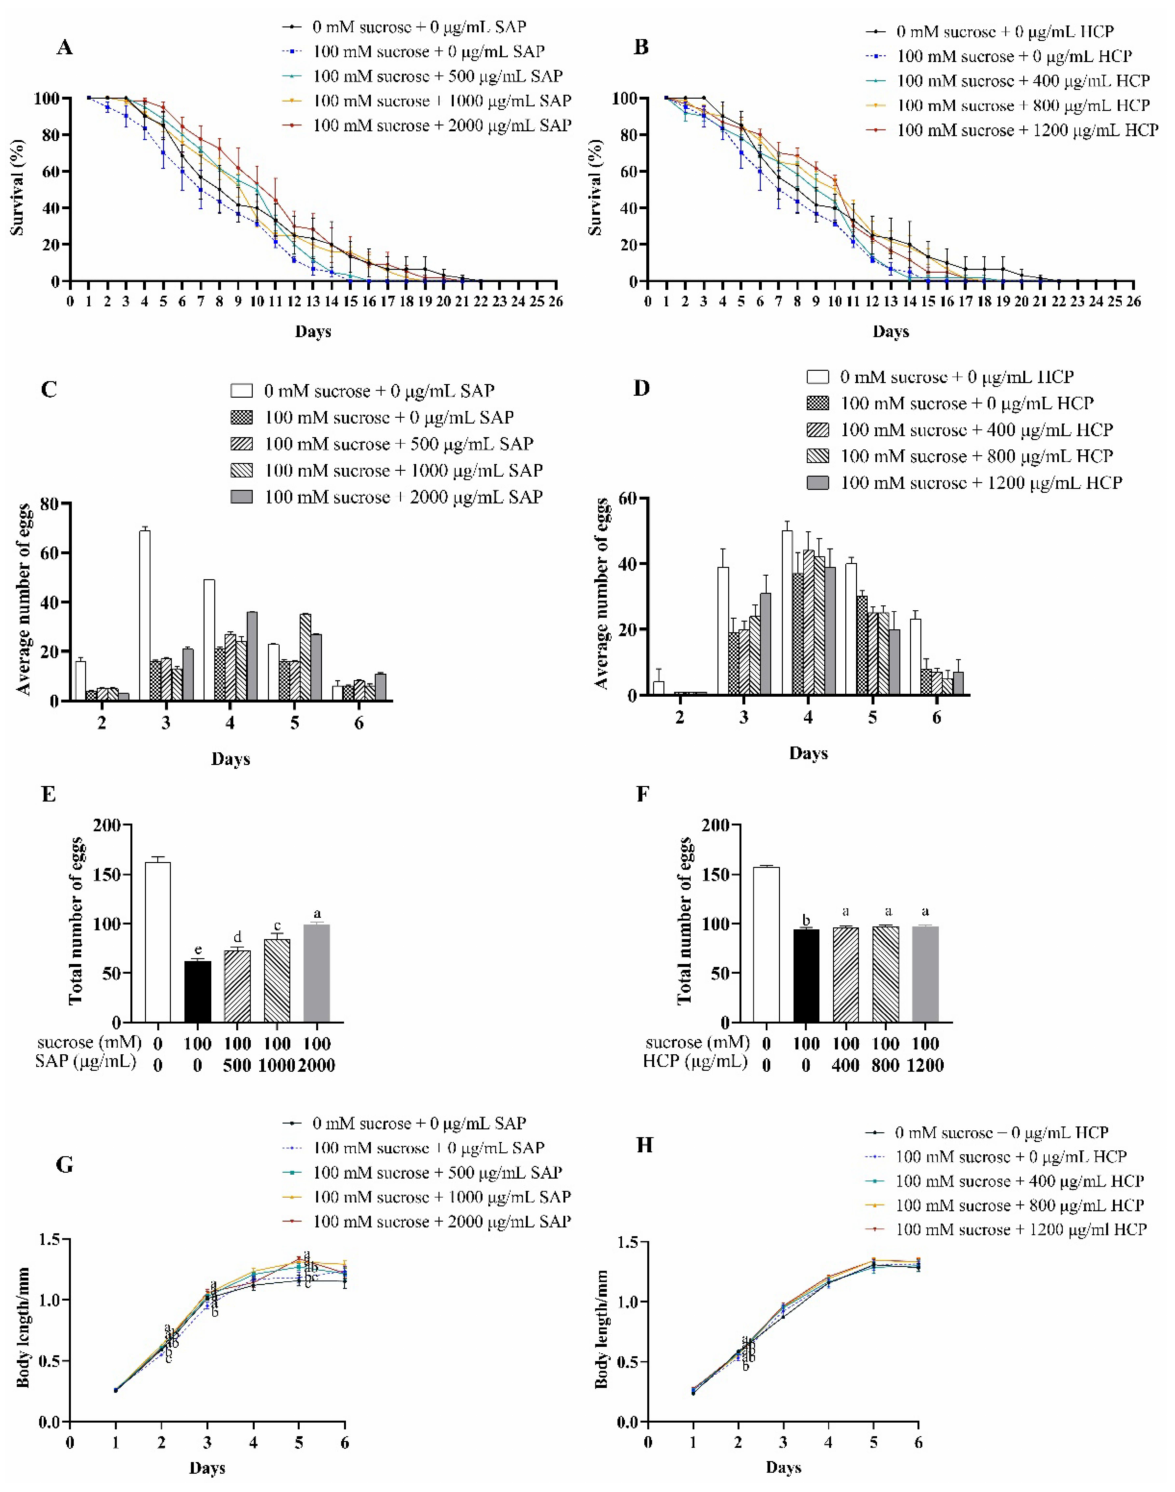
Figure 4. Effects of SAP and HCP on lifespan, reproduction, and body length of the sucrose-incubated C. elegans . ( A , B ): effects of SAP ( A ) and HCP ( B ) on the lifespan of sucrose-incubated C. elegans . ( C , D ): effects of SAP ( C ) and HCP ( D ) on the average number of eggs of sucrose-incubated C. elegans on each day. ( E , F ): effects of SAP ( E ) and HCP ( F ) on the total number of eggs of sucrose-incubated C. elegans in the entire spawning period. ( G , H ): effects of SAP ( G ) and HCP ( H ) on the body length of sucrose-incubated C. elegans . Data are presented as mean ± SEM (n = 30). Values without a common letter are significantly different at p <